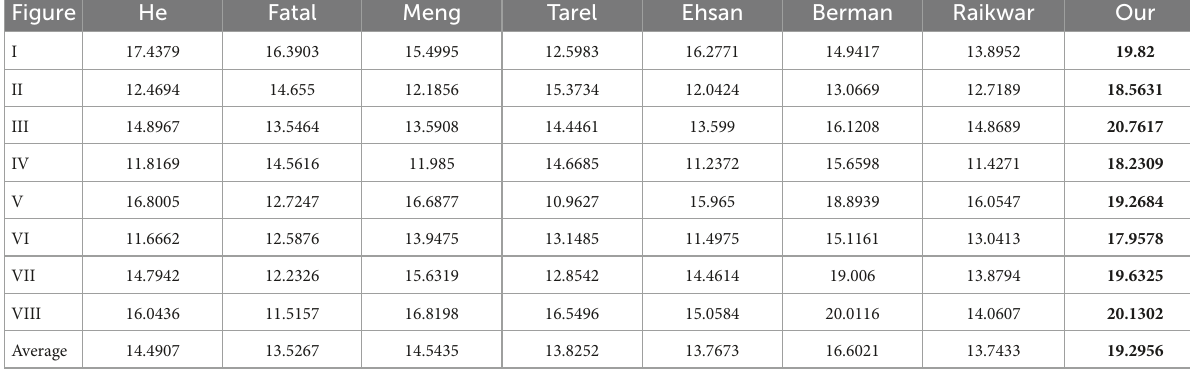
TABLE 1 Comparison of peak signal-to-noise ratio (PSNR) of the defogging images. Figure He Fatal Meng Tarel Ehsan Berman Raikwar Our